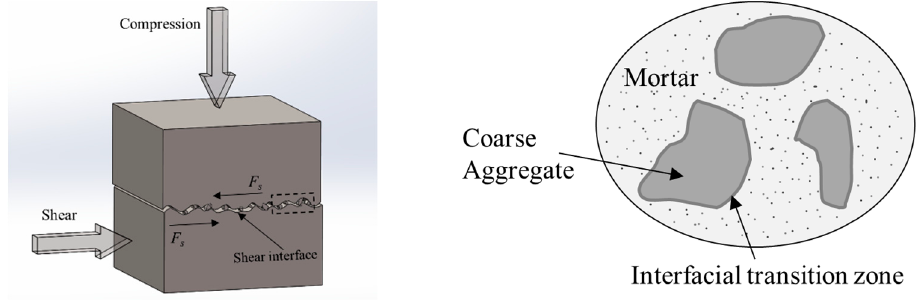
Figure 10. Compression–shear multiaxial stress mechanism model of recycled concrete.